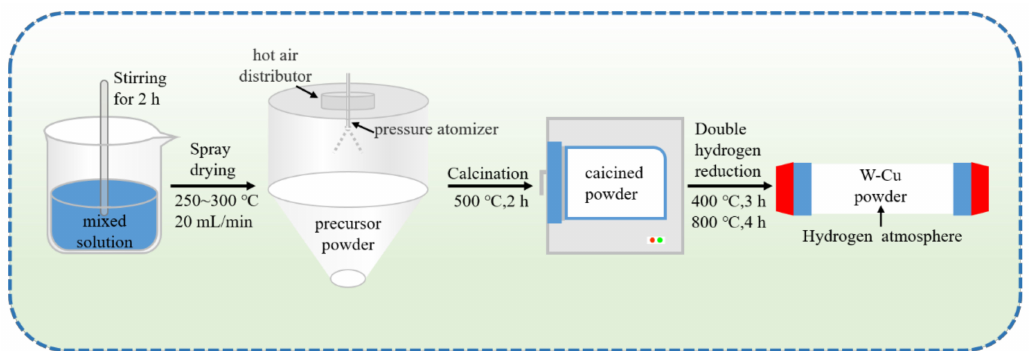
Figure 1. The preparing process of Cu-W composite powders.